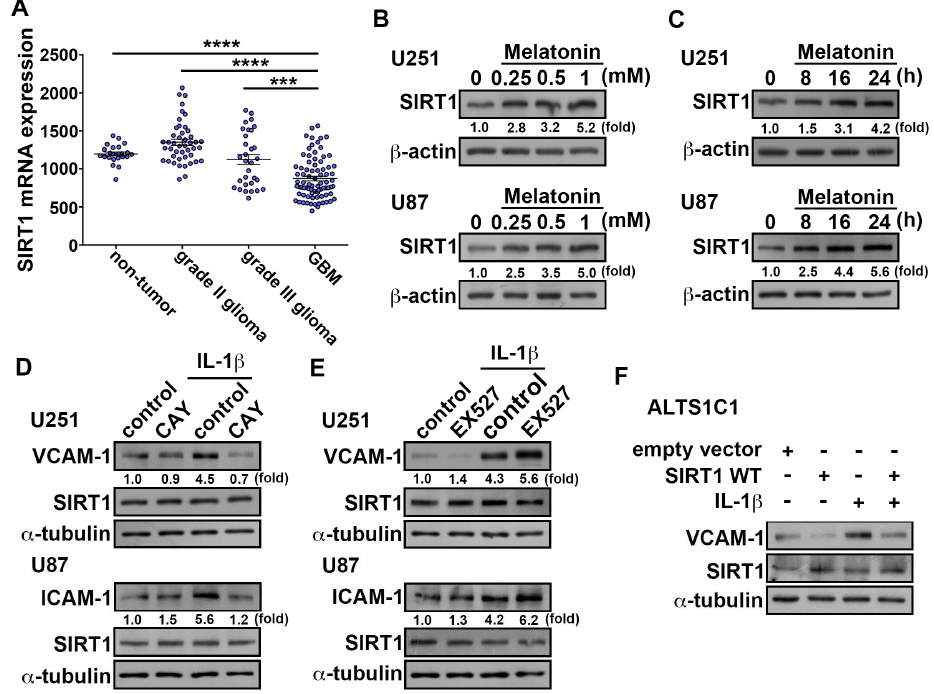
Figure 4. Upregulation of SIRT1 attenuates IL-1 β -induced ICAM-1 and VCAM-1 expression in GBM. ( A ) Messenger RNA levels of SIRT1 in glioma patient specimens obtained from GSE4290